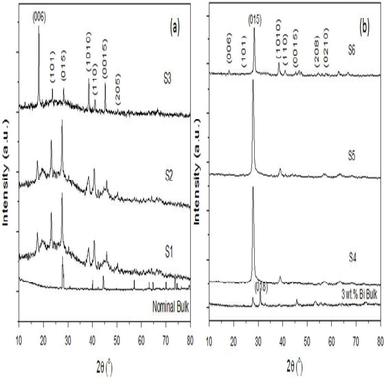
XRD spectra of the Bi2Te3 bulk material and the thin films as-deposited and annealed in vacuum and N2 atmospheres.